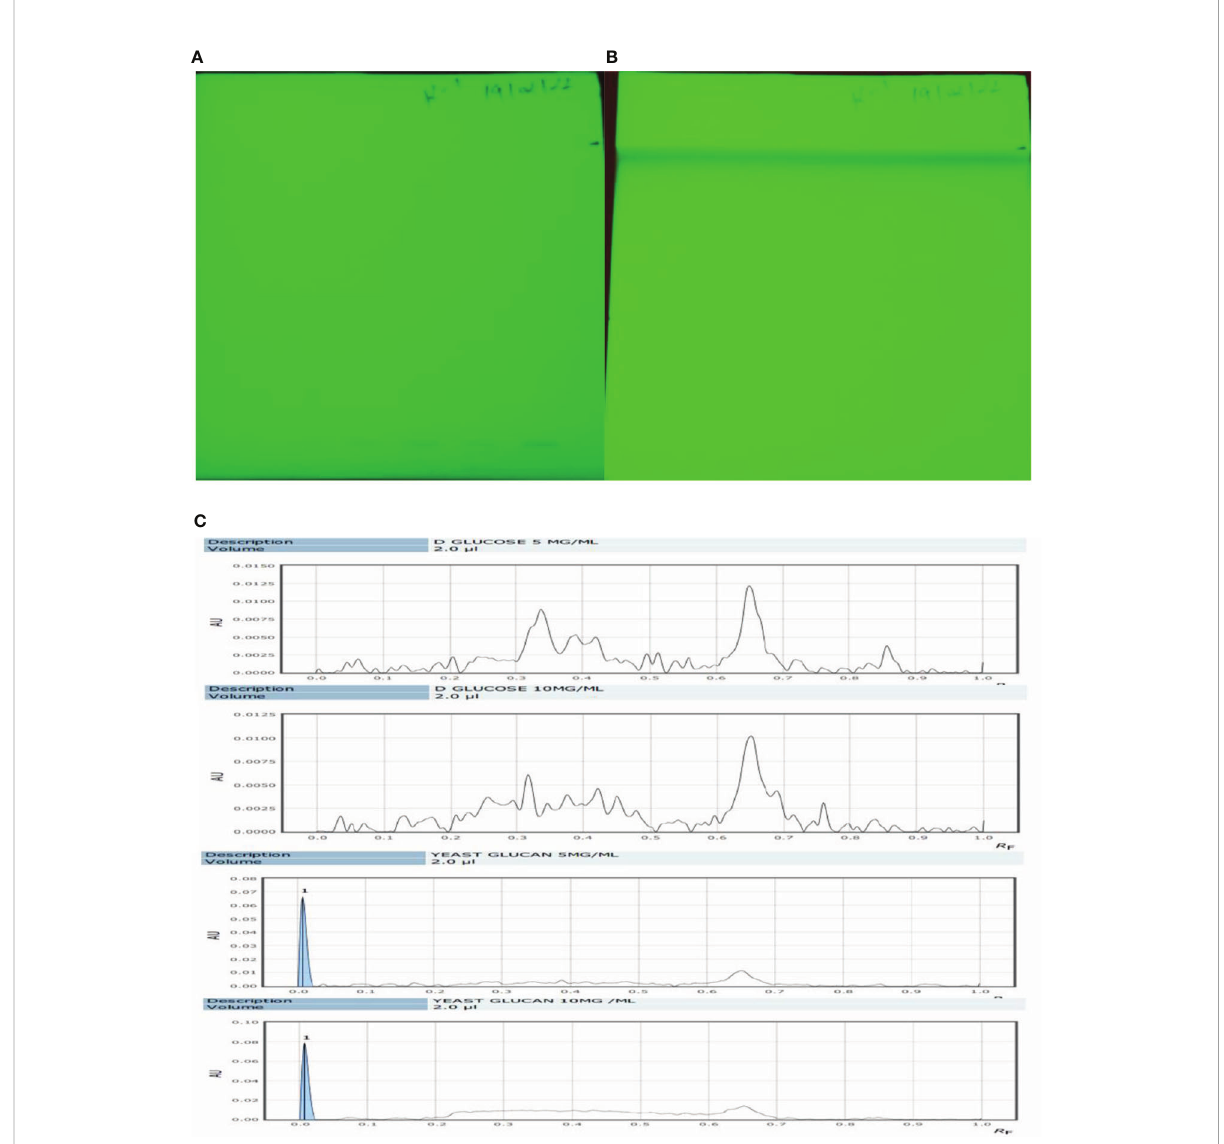
FIGURE 5 HPTLC analysis. (A) The silica plate after the spotting of the sample. (B) After movement in mobile phase N-butanol/methanol/water in the ratio 5.2:2.7:2.1 (v/v/v). (C) Recorded spectra in HPTLC. D -Glucose was taken as standard and showed its major peaks at Rf (retention factor) value of 0.6 – 0.7. The same pattern was observed in the case of b -glucan with peaks at 0.6 – 0.7. HPTLC, high-performance thin-layer